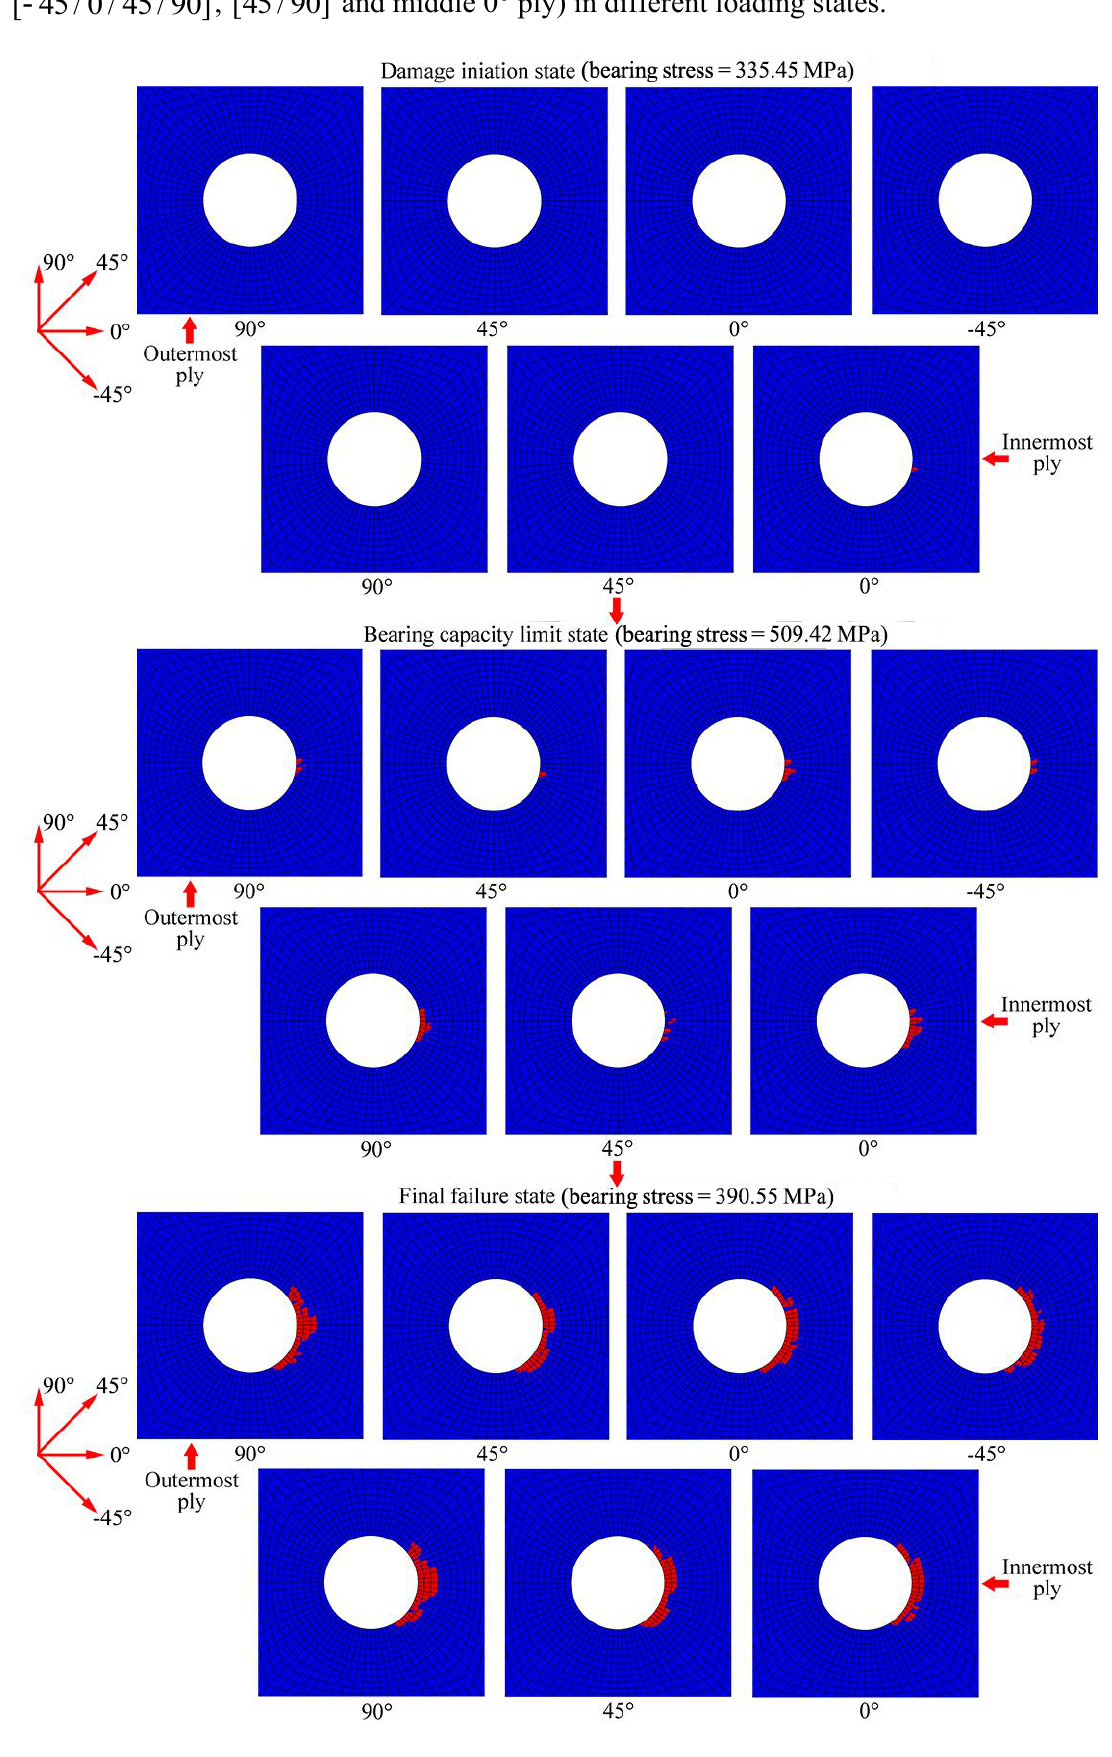
Figure 20. Illustration of delamination damage evolution at seven plies (sub-laminate [ - 45/ 0 / 45 / 90] , [45 / 90] and middle 0° ply) in different loading